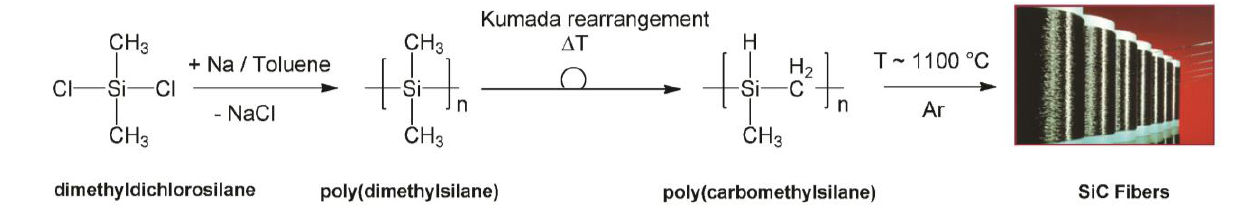
Figure 2. Yajima process for the synthesis of silicon carbide (SiC) ceramic fibers (reprinted with permission from Wiley)